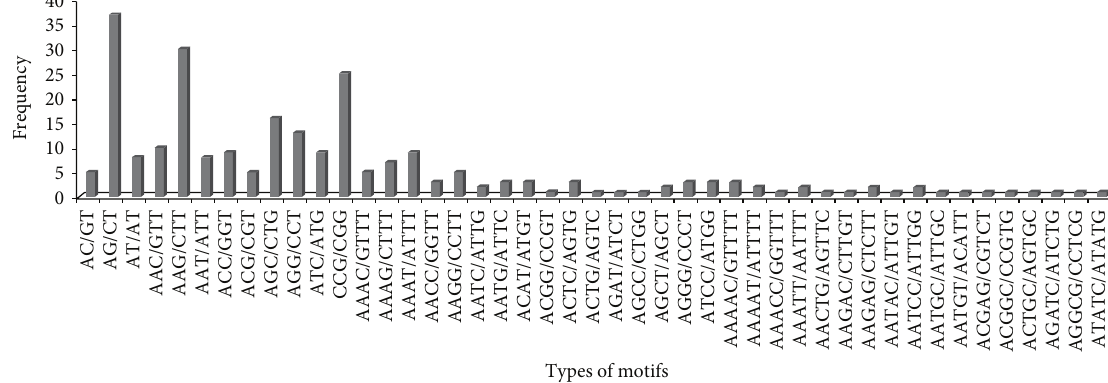
Figure 1: Details of motifs comprising di-, tri-, tetra- and pentanucleotides with sequence complementarity.